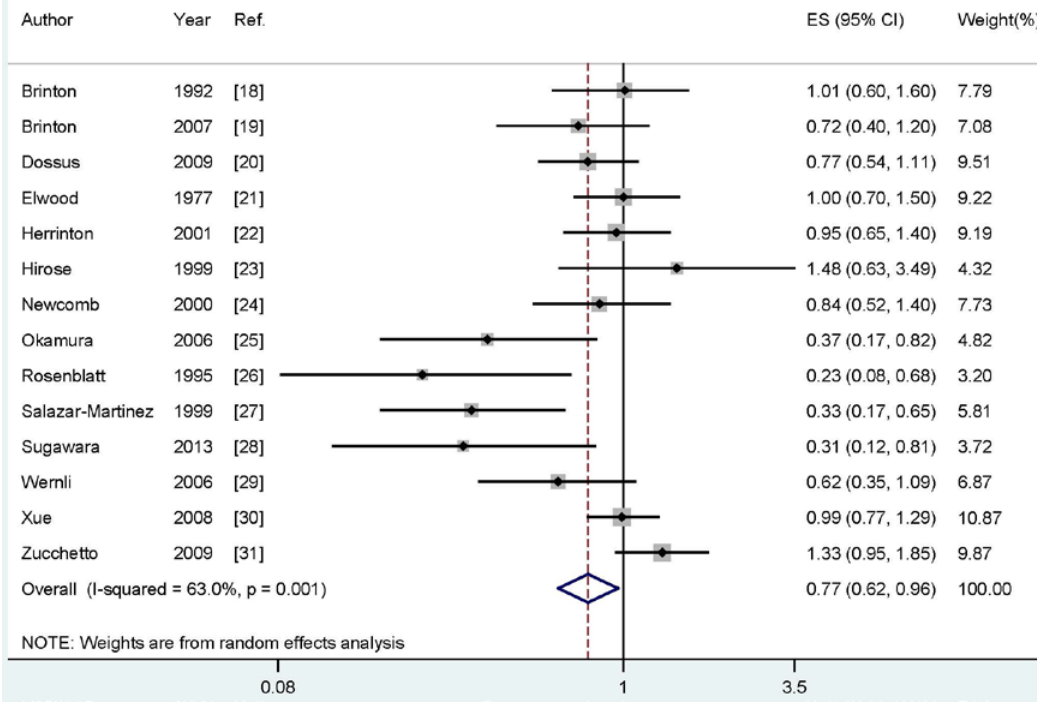
Figure 2. The forest plot of the association between breastfeeding and endometrial cancer risk.